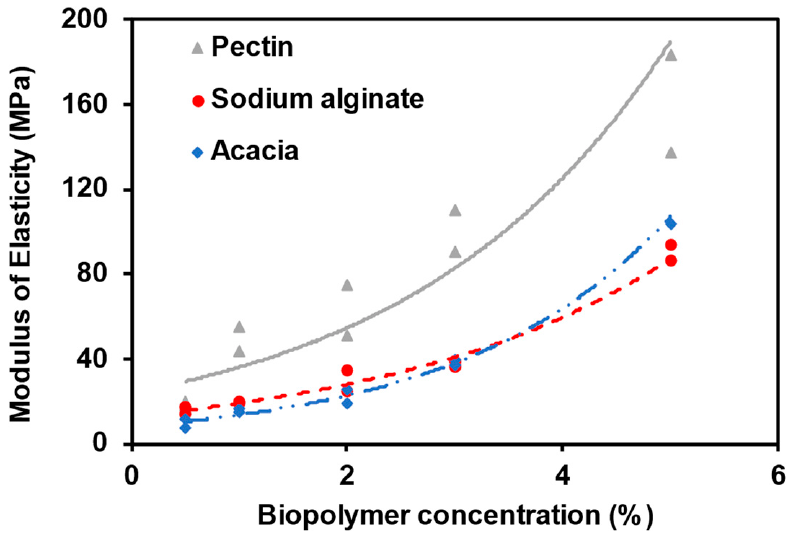
Figure 3. Effect of the biopolymer concentration on the stiffness of the modified sand after a curing period of seven days.